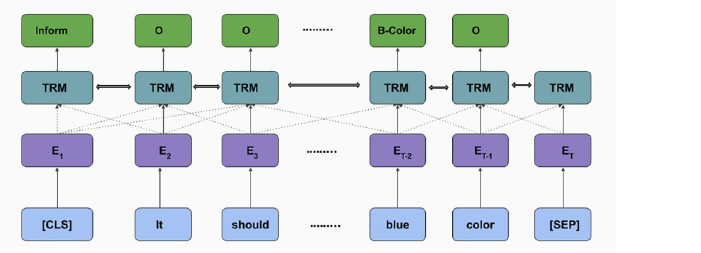
Fig 8. BERT for joint intent classification and slot filling.